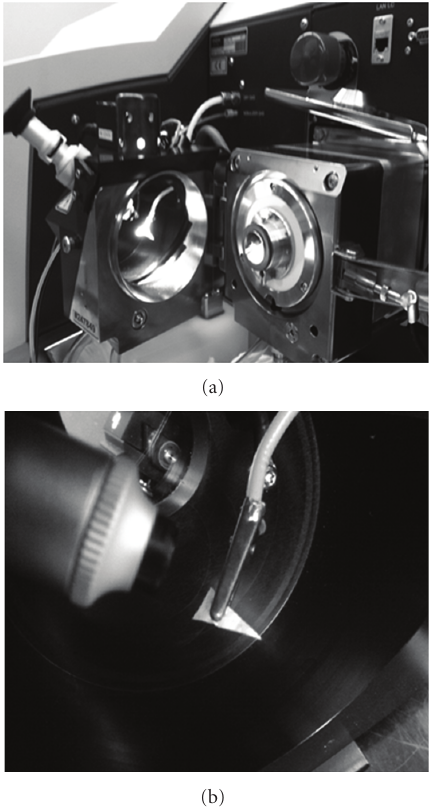
Figure 1: PS source utilizing a modified Bruker nano-ESI source, a copper clip, and cable to ground the paper triangle to the chasse of the instrument.